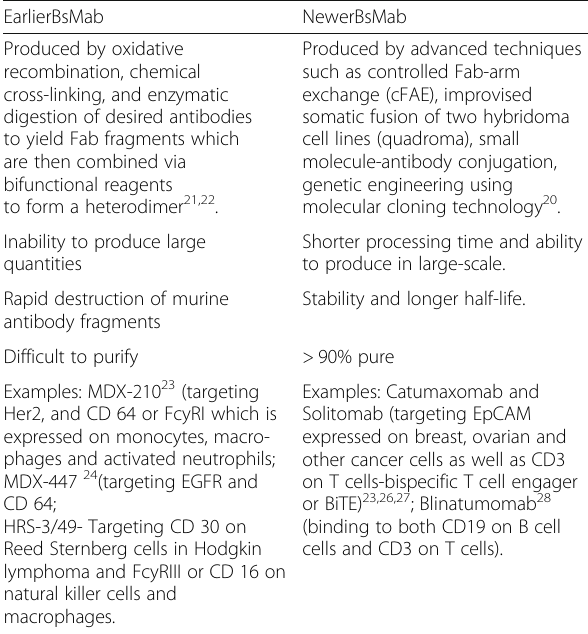
Table 2 Production, limitations, and examples of first and subsequent generations of BsMab